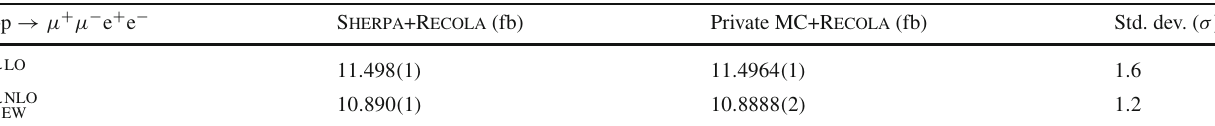
Table 11 Total cross sections calculated for pp → μ + μ − e + e − at LO and NLO EW with the Sherpa + Recola interface, compared against the benchmark numbers from Ref. [27]. The difference is expressed in standard